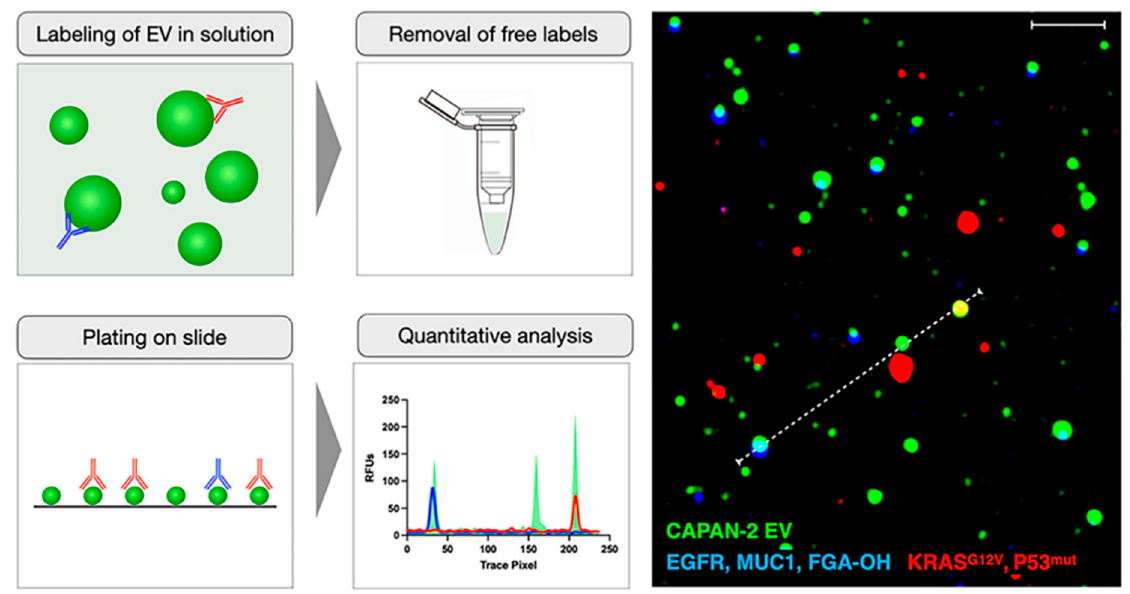
Figure 10. Synopsis of the sEVA technique. Re-used with permission from Ref. [86] (Copyright, 2022 Elsevier, reproduced with permission from Elsevier Ltd.).